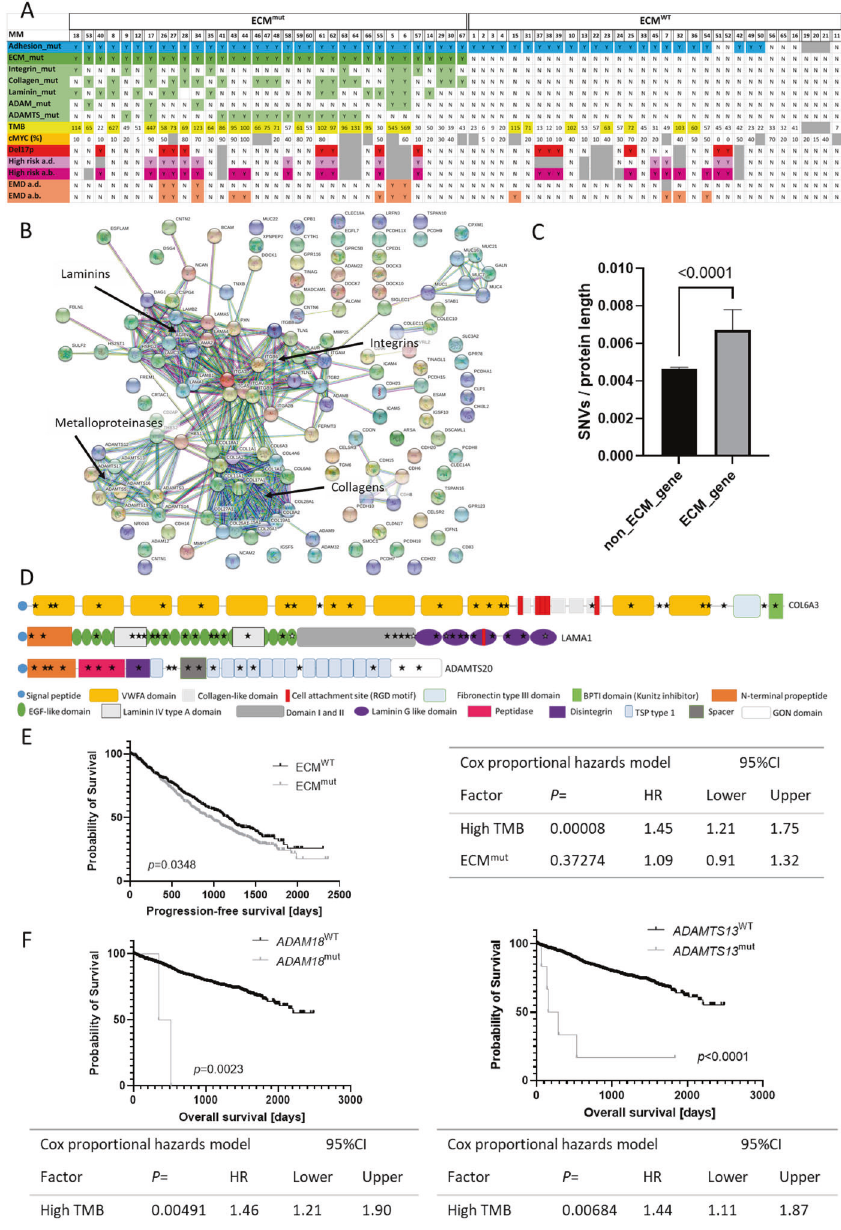
Fig. 1 ECM gene mutations as prognostic markers in MM. A Representation of the mutation status of patients with and without mutations in adhesion genes (blue), ECM genes (green) (ECM mut and ECM WT ) and the TMB (yellow). Further, cMyc protein expression (orange), del17p status (red), overall high-risk status at diagnosis (a.d.) (light pink) and at biopsy (a.b.) (dark pink) and information on the presence of extramedullary disease (EMD) (salmon) are shown. Individual patients are separated by small gaps. B STRING network analysis of mutated adhesion genes in our WES study cohort revealed clusters in integrin, collagen, laminin and metalloproteinase genes (ADAMs, ADAMTS). C ECM genes contained signi fi cantly more SNVs relative to the protein length than other protein-coding genes within the MMRF WES dataset. Non-protein-coding genes were excluded from the analysis (Table S1). Data shown is median with 95% CI. Statistical test was Mann-Whitney- U . D Visual representation of domains and structure of proteins encoded by the three ECM genes most recurrently affected by mutations: COL6A3 , LAMA1 and ADAMTS20 . For all other ECM molecules and more information on mutations see Fig. S1 and Table S3. Information on protein structure and domains was obtained from the Uniprot knowledgebase. E PFS was signi fi cantly shorter (median PFS 938.0 vs. 1176.0 days) in ECM mut patients compared to ECM WT patients. Comparisons were performed using the Kaplan Meier method and Log Rank test. Table shows Hazard ratios (HR) for high TMB and ECM mutations calculated using the Cox proportional hazards model in SPSS. F Mutations in ADAM18 and ADAMTS13 were associated with a signi fi cantly shorter OS (median 349.0 days vs. not reached and 154.0 vs. not reached, respectively). Tables below Kaplan Meier plots show HRs calculated using the Cox proportional hazards model for high TMB and ADAM18 mut or ADAMTS13 mut . Graphs were created using GraphPad Prism